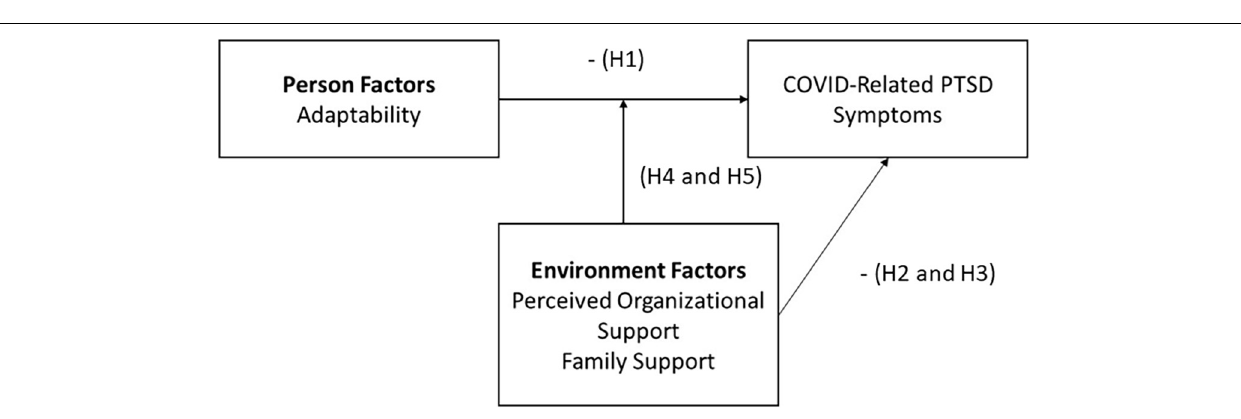
FIGURE 2 | Graphical depiction of study hypotheses and variables. PTSD, post-traumatic stress